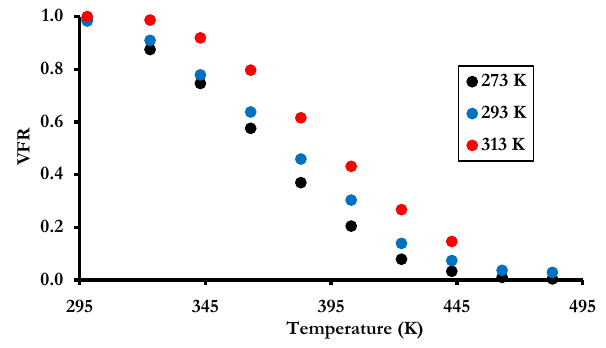
Fig. 7. Chemical composition of the organic aerosol at 1–1.5h after the addition of the precursor. Relative contribution compared to the total amount of three selected acidic oxidation products, of α - pinene at different temperatures, pinonic acid (blue bars), pinic acid (red bars) and MBTCA (green bars). Error bars were calculated from the relative standard deviation of the averaged measurement